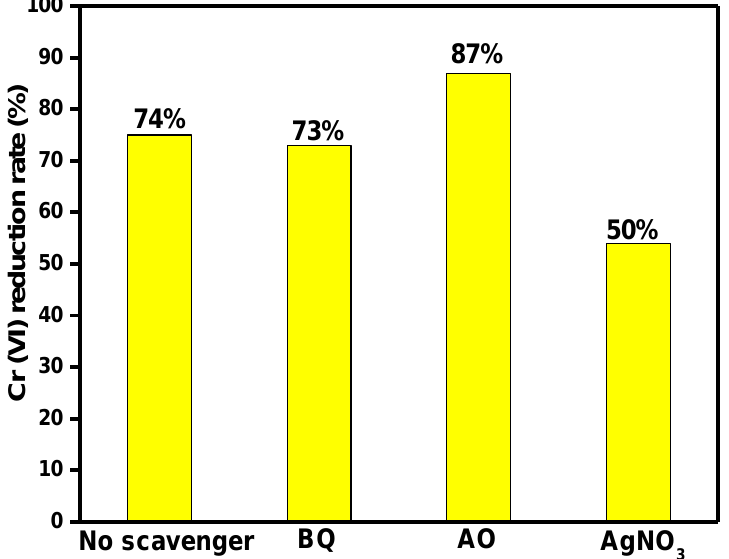
Figure 8. The reduction rate of Cr(VI) in the presence of different scavengers under visible light irradiation within 60 min.